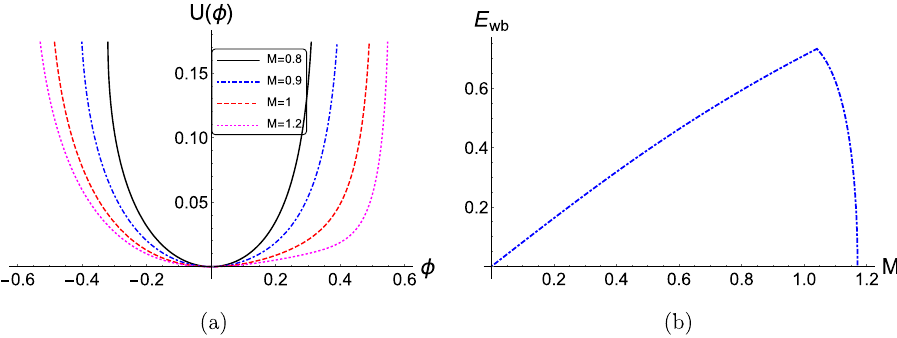
Figure 4. (Color online) ( a ) The effect of the variation of the phase speed (Mach number) M on the pseudopotential U (φ) is depicted, versus the electrostatic potential φ . ( b ) The variation of the minimum normalized wave-breaking electric field amplitude E wb versus the Mach number M . The parameter values are: δ = 0.5 , κ = 2.5 , µ = 1 and Q = 1 . The numerical values adopted here, as imposed by the maximum allowed value(s) of U (φ) , i.e. U max = I , are presented in Table IV (see Online Appendix